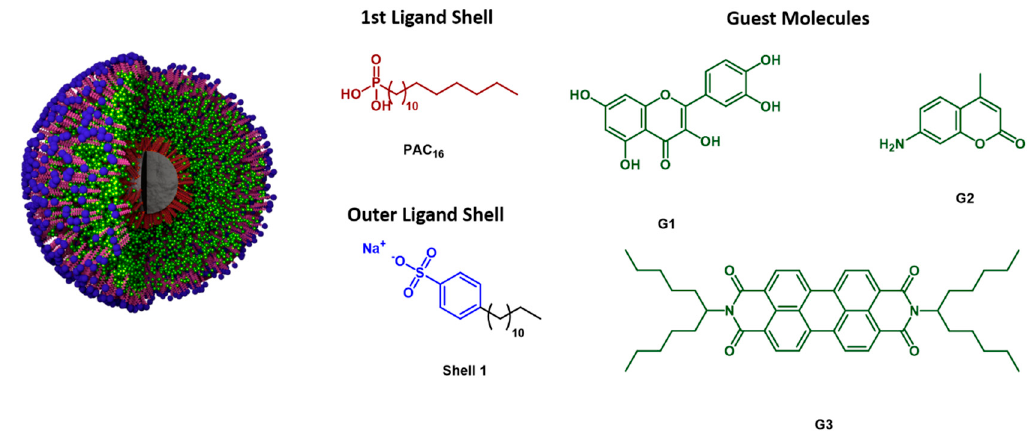
Figure 1. Shell-by-Shell (SbS) coated nanocarrier assemblies that are loaded with guest molecules G1 (quercetin), G2 (7-amino-4-methylcoumarin), and G3 (perylendiimide). Inorganic nanoparticle core: TiO 2 or Al 2 O 3.